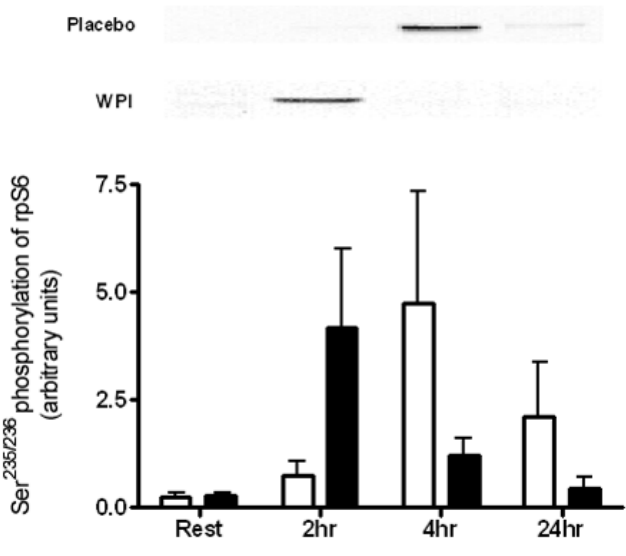
Figure 5 Phosphorylation of rpS6 at Ser 235/236 in human skeletal muscle at rest and 2, 4